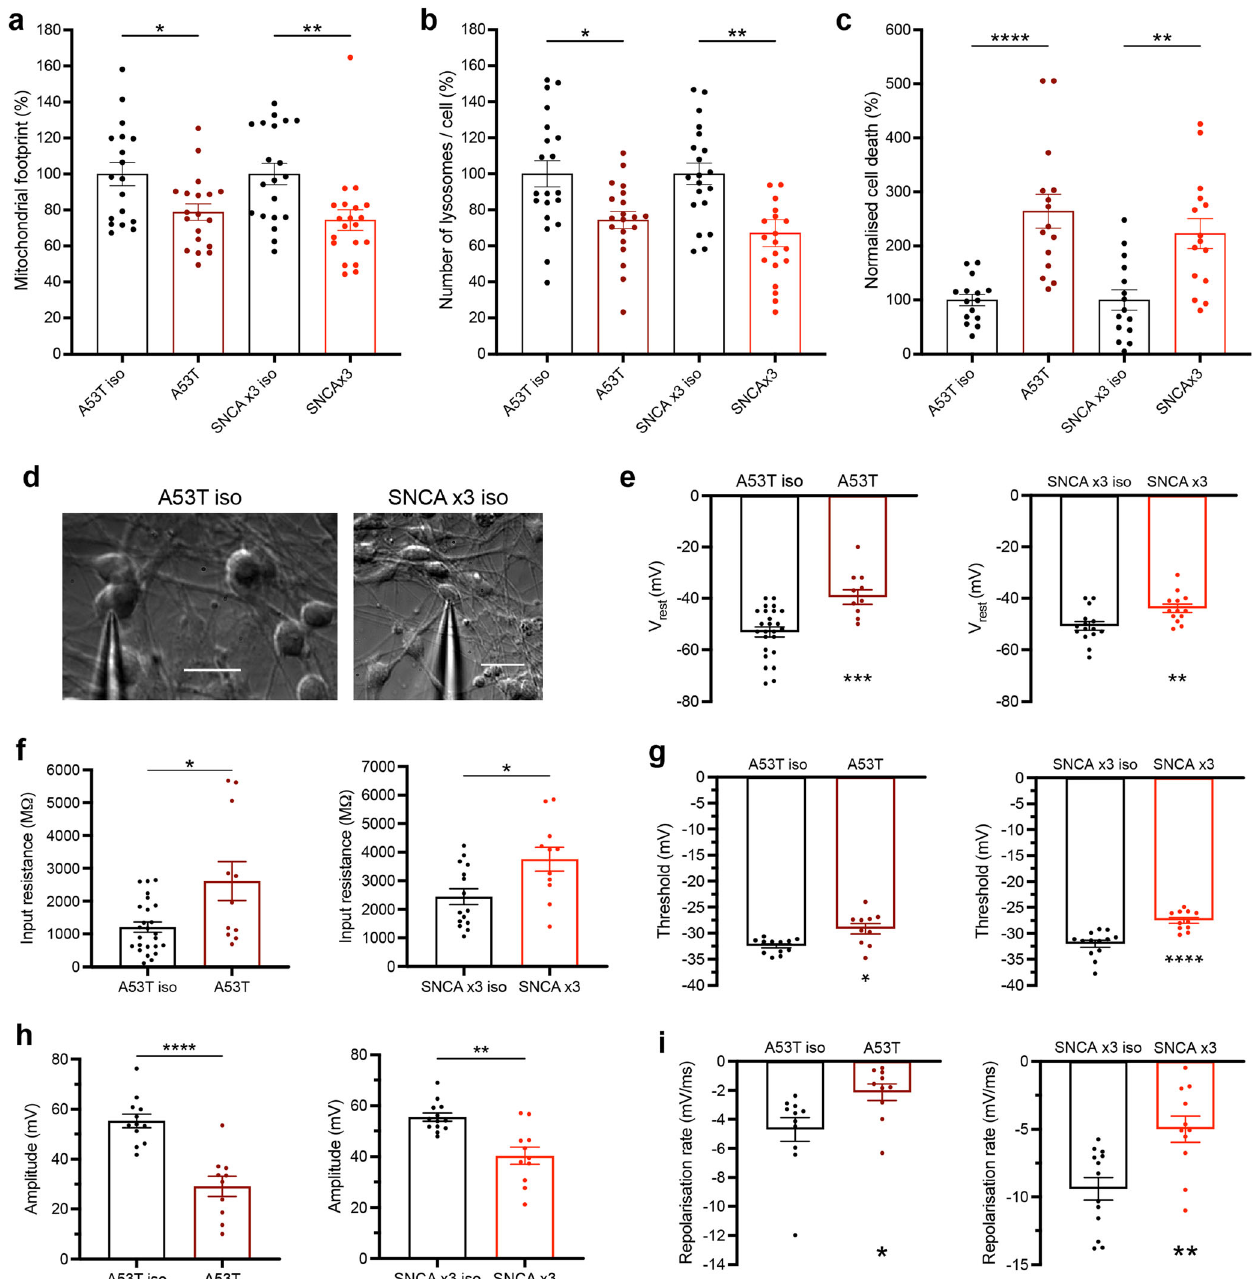
Fig. 7 Functional consequences of SNCA mutations in human mDA neurons. a The normalised basal mitochondrial footprint measurement plotted out in control, A53T, and SNCA x3 >day 62 old neurons (* P < 0.05, ** P < 0.005, one-way ANOVA). b The normalised basal number of lysosomes per cell in controls, A53T and SNCA x3 >day 62 old neurons (* P < 0.05, ** P < 0.005, one-way ANOVA). c The normalised percentage of cell death in control, A53T, and SNCA x3 >day 62 old neurons (** P < 0.005, **** P < 0.0001 one-way ANOVA). d Representative bright- fi eld images showing >day 70 neurons patched for electrophysiological recordings. Scale bar = 20 μ m. e Quanti fi cation of electrophysiological recordings showing the resting membrane potential in control and A53T neurons, and control and SNCA x3 neurons (** P = 0.0068, *** P = 0.0008, Welch ’ s t test). f Quanti fi cation of electrophysiological recordings showing the input resistance in control and A53T neurons, and control and SNCA x3 neurons (* P < 0.05, Welch ’ s t test). g Quanti fi cation of the threshold for AP generation in control and A53T neurons, and control and SNCA x3 neurons (* P < 0.05, **** P < 0.0001, Welch ’ s t test). h Quanti fi cation of the AP amplitude in control and A53T neurons, and control and SNCA x3 neurons (** P < 0.005, **** P < 0.0001, Welch ’ s t test). i Quanti fi cation of the AP repolarisation rate in control and A53T neurons, and control and SNCA x3 neurons (* P < 0.05, ** P < 0.005, Welch ’ s t test). All values are plotted as ±s.e.m. All N numbers for each experiment can be found in Supplementary Table sequencing. Approximately 10,000 cells were loaded for each suspension was measured using Trypan blue and the Eve sample into a separate channel of a Chromium Chip G for use in automatic cell counter. Each sample presented a concentration the 10X Chromium Controller (cat: PN-1000120). The cells were between a 1200 – 1700 cell/µl and viability ranged between 55 and partitioned into nanoliter scale Gel Beads in emulsions (GEMs) and 68%, samples with a viability above 57% were used for